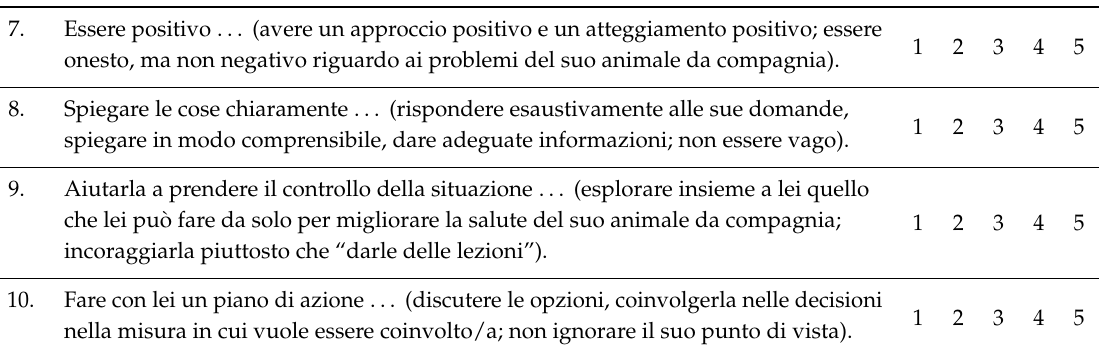
Fare con lei un piano di azione . . . (discutere le opzioni, coinvolgerla nelle